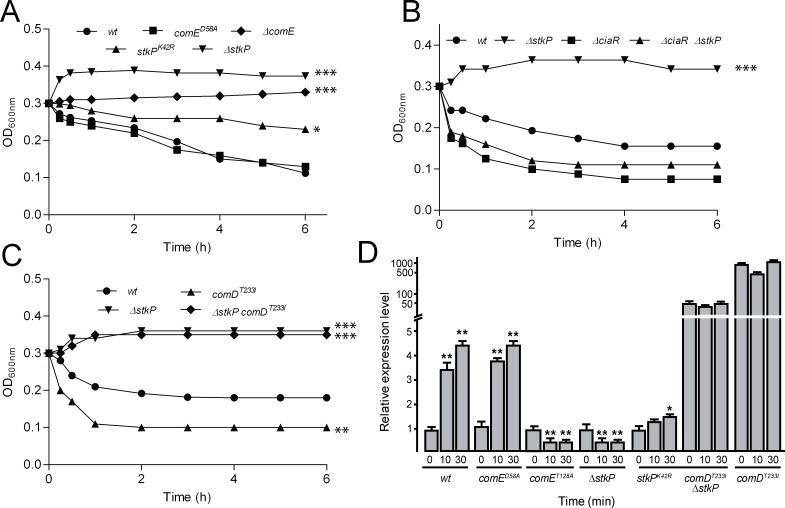
Evaluation of ASIL and comE expression in S. pneumoniae mutants.Autolysis was measured as a change in OD620nm over 6 hours. Lytic curves corresponding to specific mutants are indicated in each panel (A-C), with data being representative of at least three independent experiments. (A) ASIL is controlled by StkP but it does not require Asp58-phosphorylation in ComE. (B) StkP does not participate in the CiaRH-regulated ASIL pathway. (C) StkP is involved in the ComE-regulated ASIL pathway. References: *p< 0.05; **p< 0.01; ***p< 0.001, these p-values were referred to the wt strain in each panels. (D) Transcription levels of the comE gene measured in cells exposed to pH 6.0. To avoid autolysis, all mutants were constructed in a ΔlytA (autolysin deficient) background. The ΔlytA, comED58A ΔlytA, ΔstkP ΔlytA, comDT233I
ΔlytA and comET128A
ΔlytA cells were grown in ABM/pH 7.8 to the mid-exponential phase and resuspended in ABM/pH 6.0. Total RNA was extracted at 0 min, 10 min, and 30 min. The fold change in gene expression was measured by quantitative real-time PCR and calculated using the 2–ΔΔCT method. The gyrB gene was used as the internal control and the reference condition was time 0 min of strain ΔlytA. Error bars indicate the standard deviation of the mean. INSTAT software was used to perform Dunnet’s statistical comparison test for each strain with its respective basal condition (time 0 min). References: **p< 0.01; ***p< 0.001.